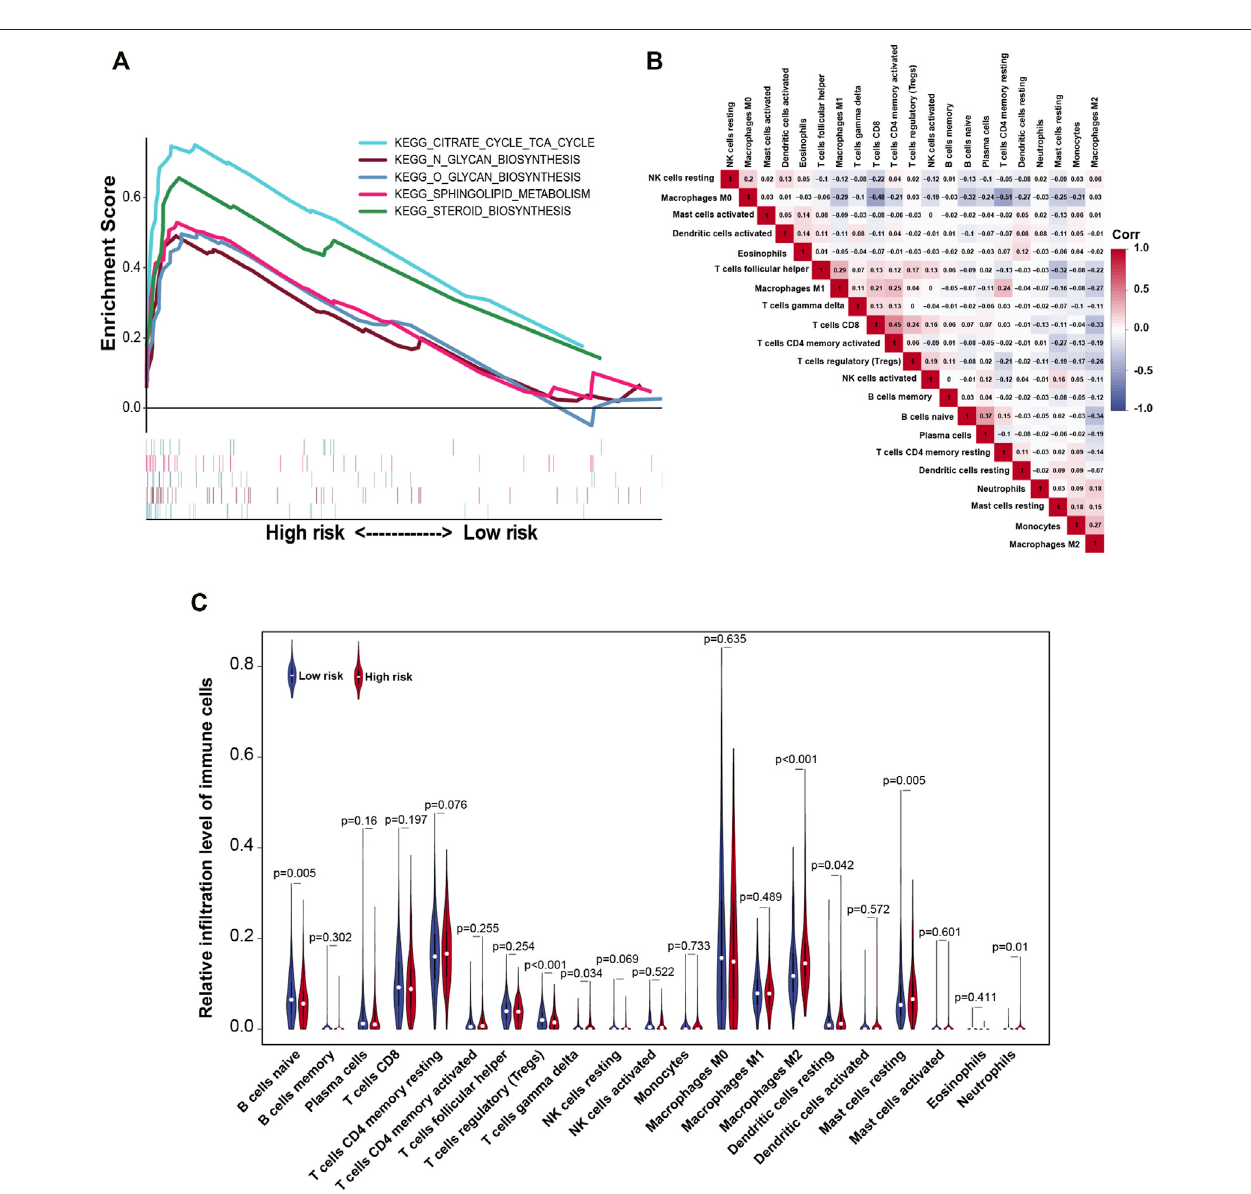
FIGURE 7 | Gene set enrichment analysis (GSEA) and the correlation between risk model and tumor-in fi ltrating immune cells. (A) Enrichment analysis of gene signaling pathways in risk models. (B) Correlation between the expressions of tumor-in fi ltrating immune cells in BC. (C) Violin plot of relative in fi ltration level of tumor immune cells in the high- and low-risk groups. Corr, Spearman correlation coef fi cient.